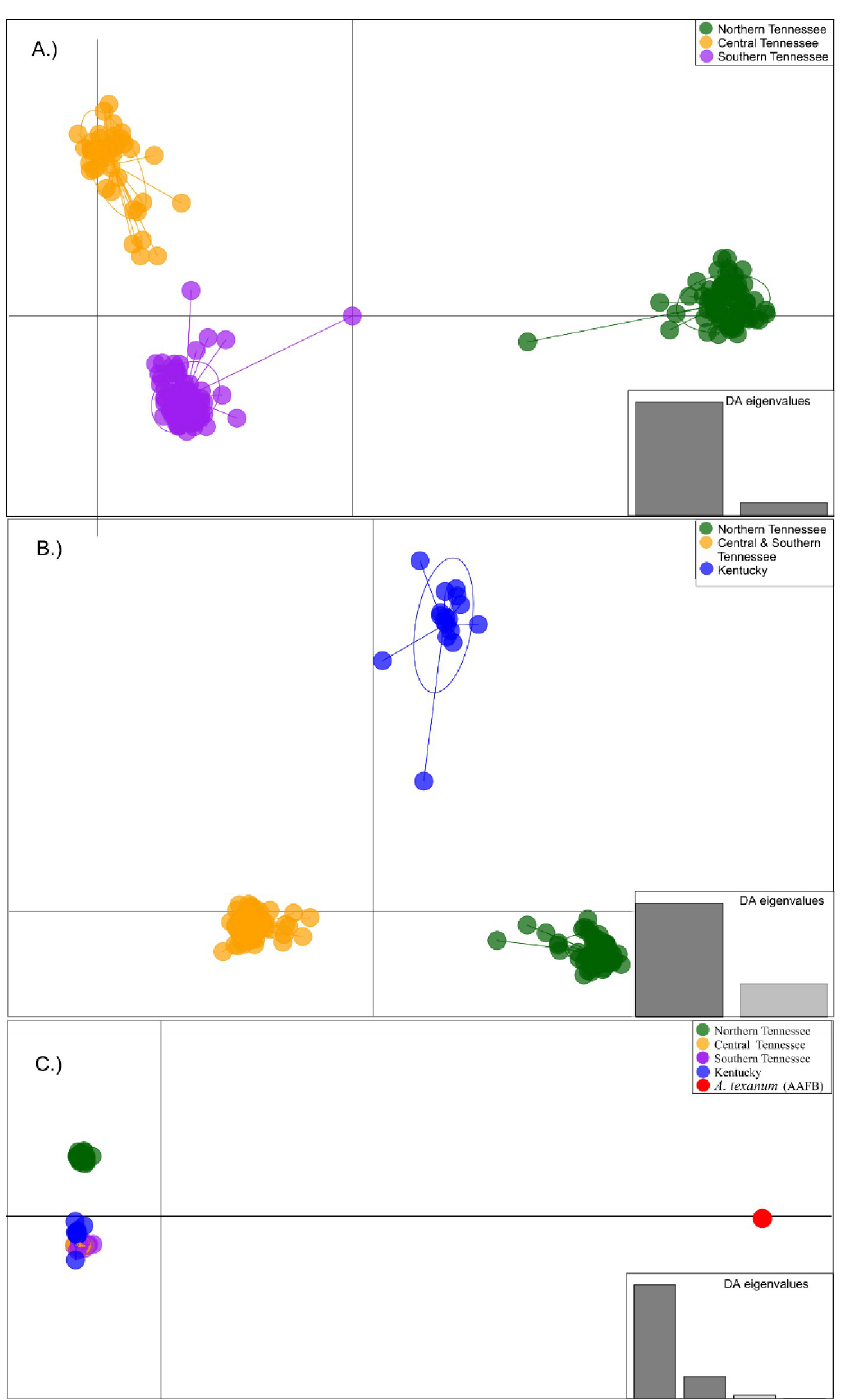
Fig 4. Scatter plot from discriminant analysis of principal components (DAPC). Scatter plots of PCA 1 and PCA 2 from DAPC analysis of SNP genotypes for A) all Tennessee A . barbouri (N = 198, K = 3), B) all Tennessee A . barbouri and samples from five populations of A . barbouri in Kentucky (N = 215, K = 3) and C) all A . barbouri and A . texanum (N = 4, K = 5). The optimal number of clusters for each analysis was determined using the Bayesian Information Criteria (BIC). The final number of principal components used in each analysis was determined using the cross- validation method.